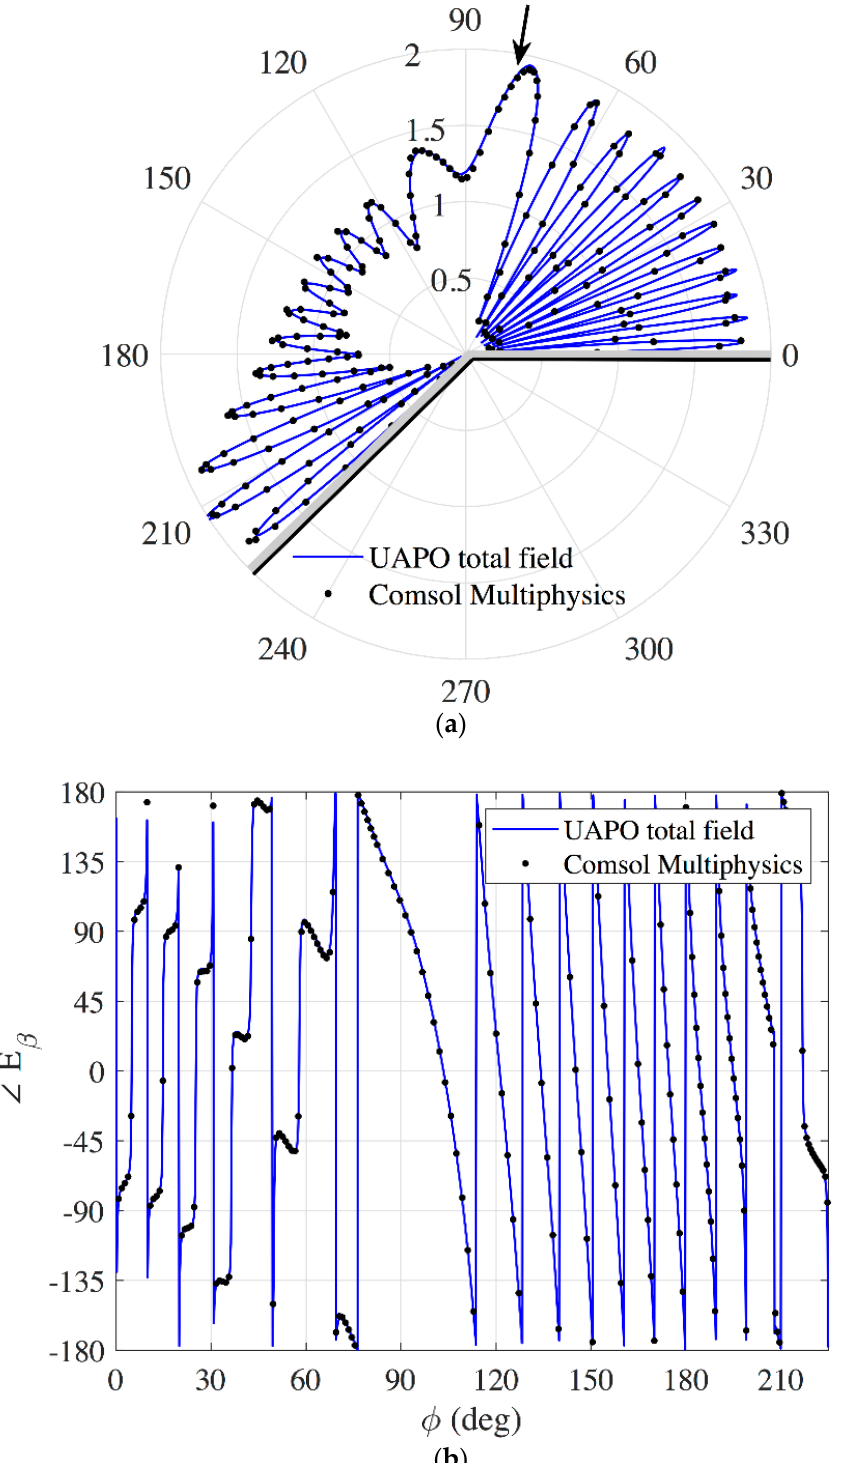
i = i = 1 , E 0 . ( a ) = 1, E i = 0. b ' f ' φ (cid:48) β (cid:48)